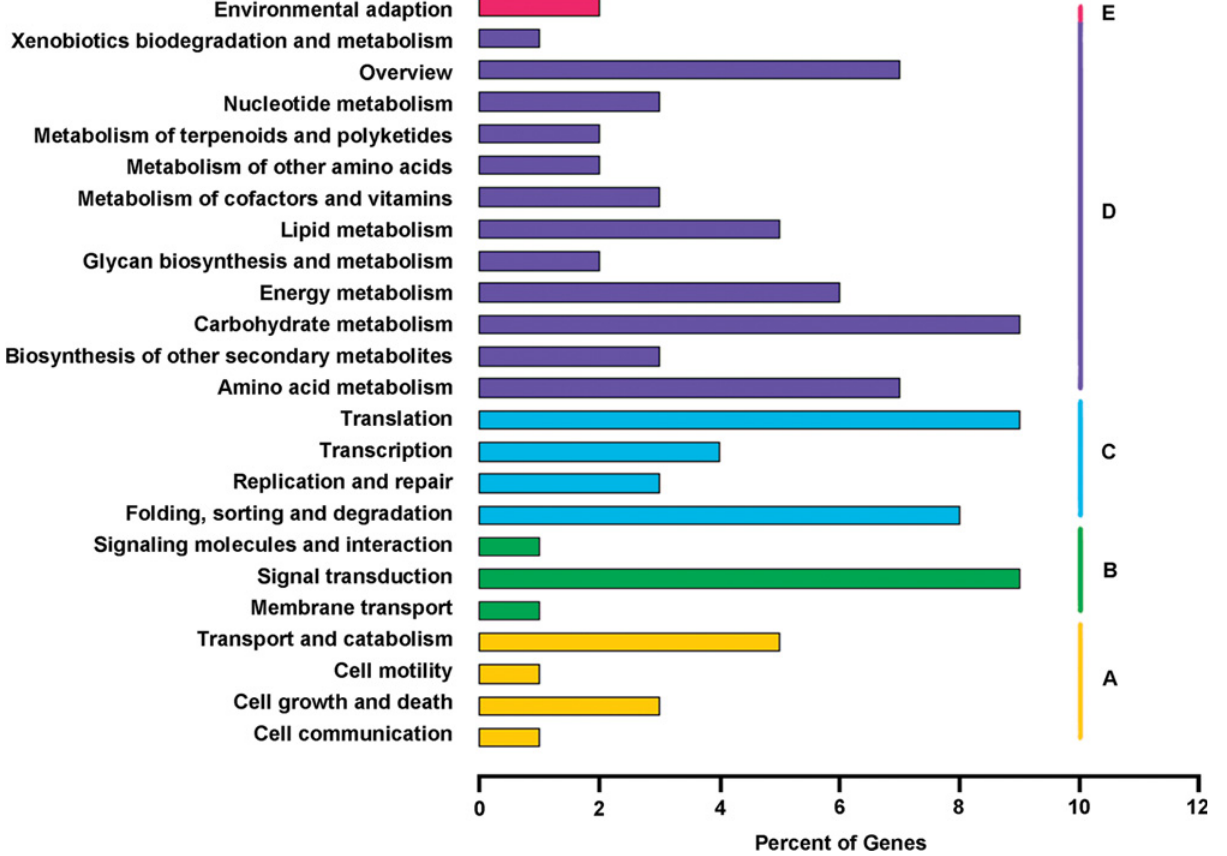
Fig 6. KEGG classification of assembled unigenes. A total of 6,452 unigenes were assigned to KEGG pathways of cellular processes (A), environmental information processing (B), genetic information processing (C), metabolism (D) and organism system (E).